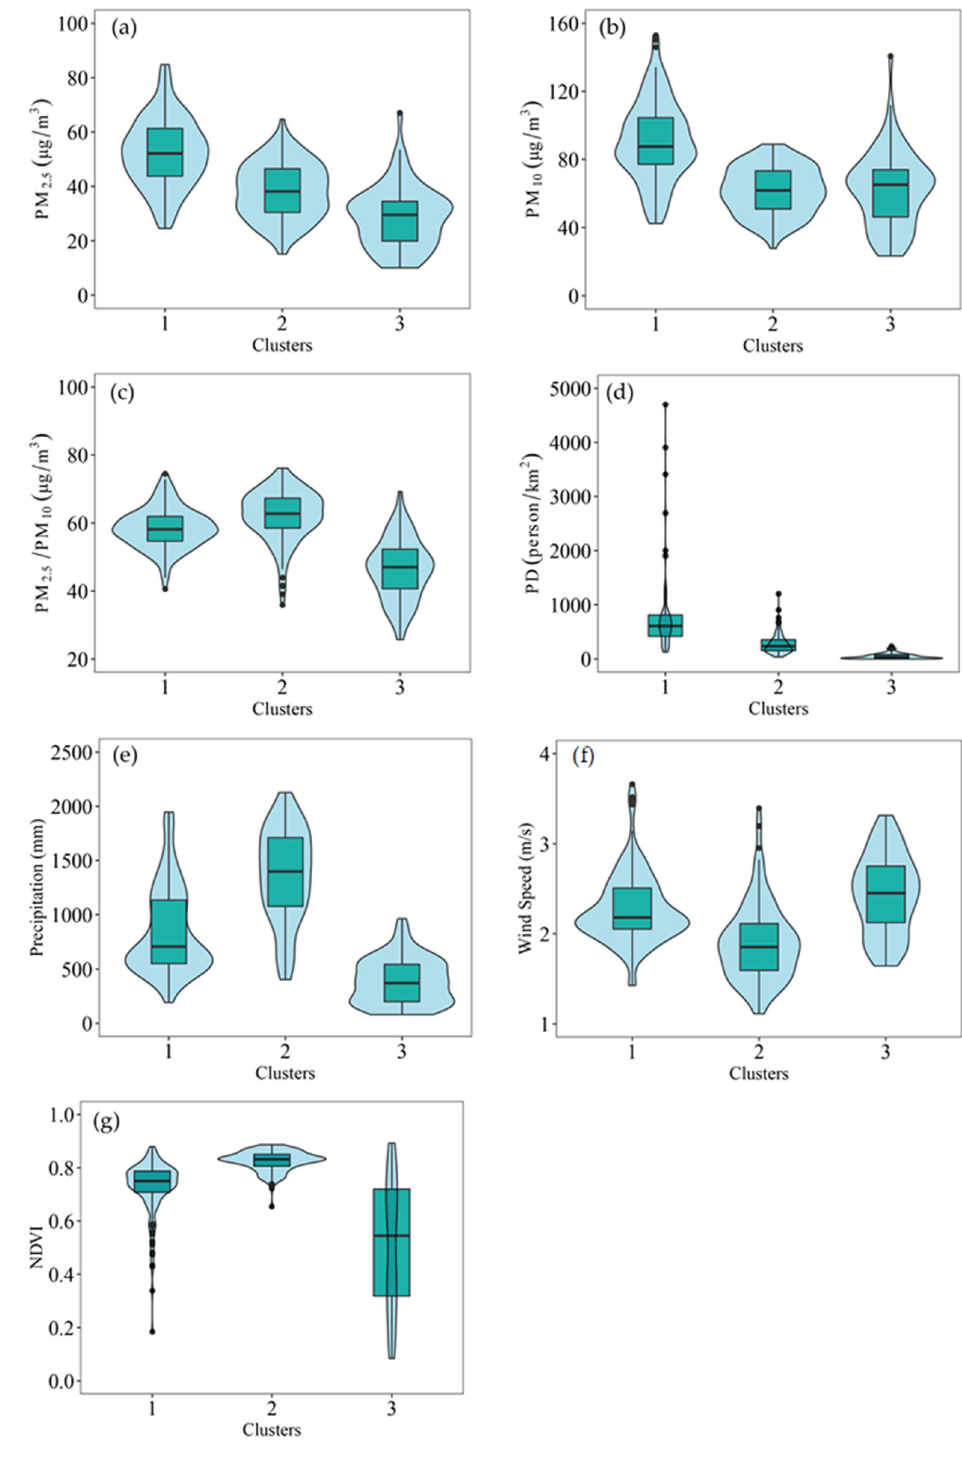
Figure 3. Variation in PM levels as well as natural and socioeconomic conditions in each cluster. ( a ) PM 2.5 characteristic in each cluster, ( b ) PM 10 characteristic in each cluster, ( c ) PM 2.5 /PM 10 characteristic in each cluster, ( d ) PD (Population density) characteristic in each cluster, ( e ) Precipitation characteristic in each cluster; ( f ) Wind speed characteristic in each cluster; ( g ) NDVI characteristic in each cluster.